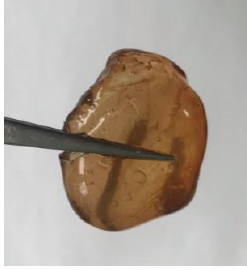
Figure 4. The hydrogel after immersion in 20% tannic acid solution.